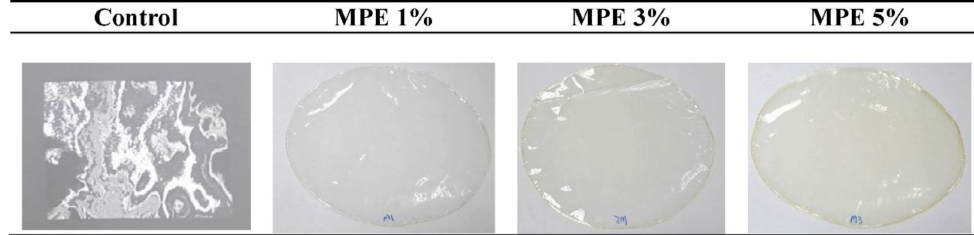
Figure 9. Gelatin films with various concentrations of mango peel extracts. Reproduced with permission from Ref. [114]. Copyright 2021